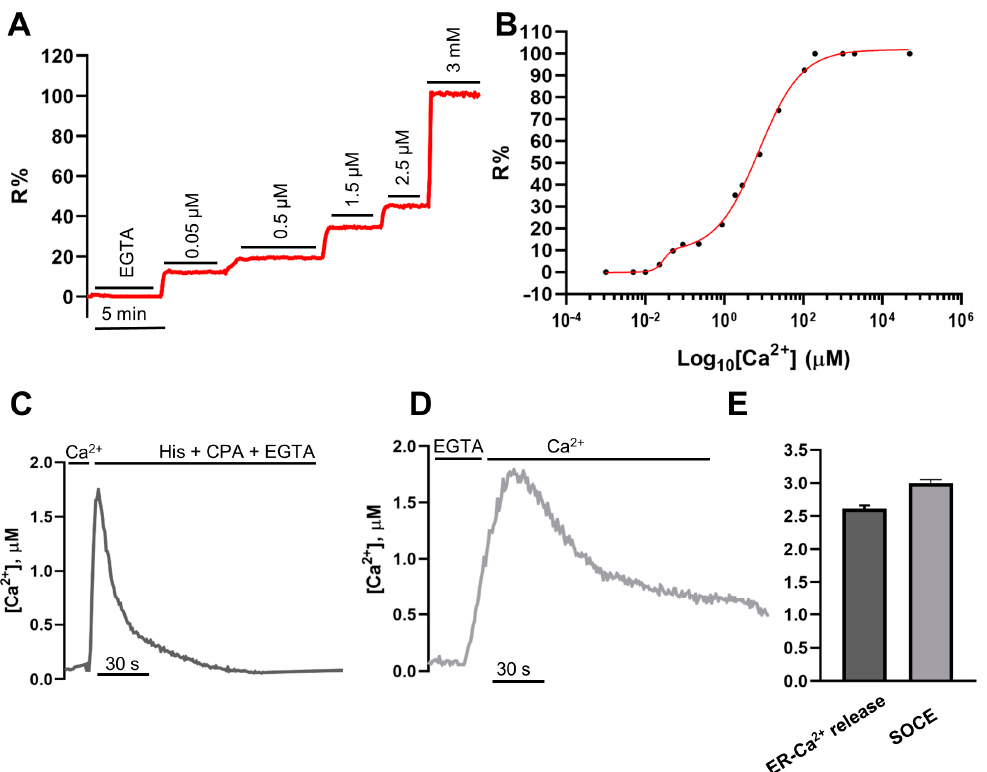
Figure 3. H2BD3mCerulean3+16 Ca 2+ affinity estimation ( A , B ). ( A ) Representative kinetic of R% in permeabilized HeLa cells transiently expressing the H2BD3mCerulean3+16 nuclear probe. Where indicated, digitonin-permeabilized cells were perfused with an intracellular medium without energy sources and containing different [Ca 2+ ]. ( A ) In the representative trace, 0.05, 0.5, 1.5, and 2.5 µ M CaCl 2 were used; 3 mM CaCl 2 was added at the end to reach maximal FRET values. ( B ) In situ Ca 2+ titration of H2BD3mCerulean3+16 along with the corresponding fit of the data plotted as mean ± SEM ( n ≥ 7) cells for each [Ca 2+ ]. Nuclear [Ca 2+ ] upon different cell stimuli ( C – E ). Representative kinetics of nuclear [Ca 2+ ] changes upon ER Ca 2+ release ( C ) or SOCE activation ( D ) in HeLa cells expressing H2BD3mCerulean3+16. Data are presented as [Ca 2+ ], mean ± SEM. ( E ) The bar chart shows nuclear Ca 2+ peaks elicited by histamine and cyclopiazonic acid (CPA) application (dark gray) or SOCE activation (light gray) in HeLa cells as mean ± SEM of n = 43 cells.